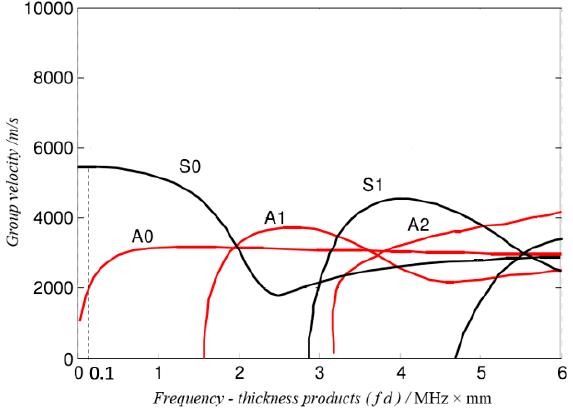
Figure 1. Dispersion curve of Lamb wave propagating in aluminium alloy plate.